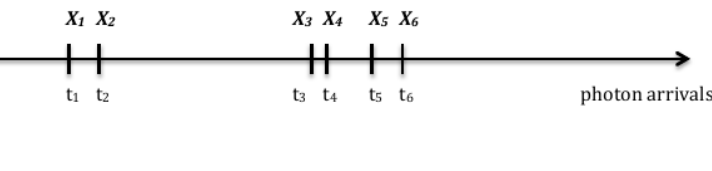
Figure 1. All photons recorded when there is no dead period.